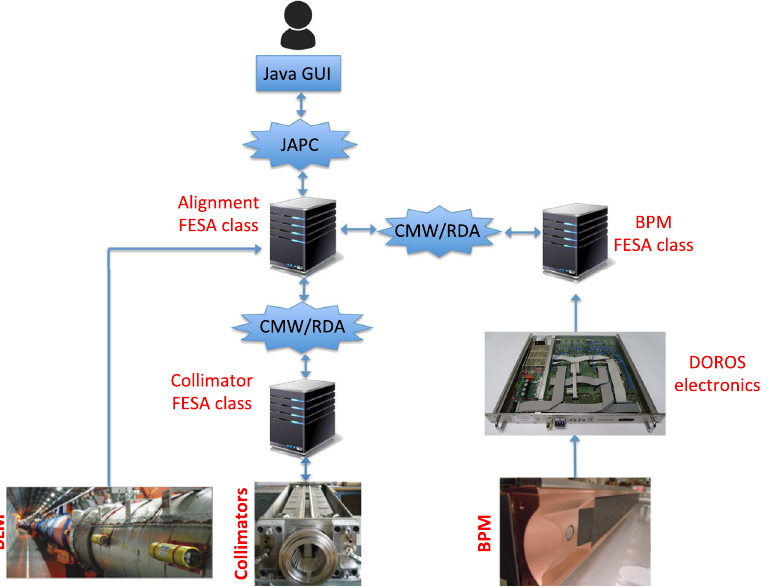
FIG. 2. Software architecture developed for the data acquisition and operation of the embedded collimator BPMs for collimator alignment and beam orbit